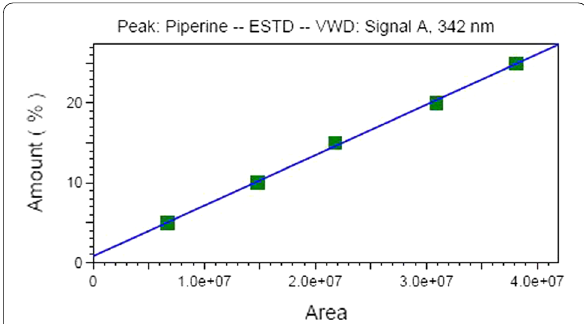
Fig. 5 Linear calibration curve for